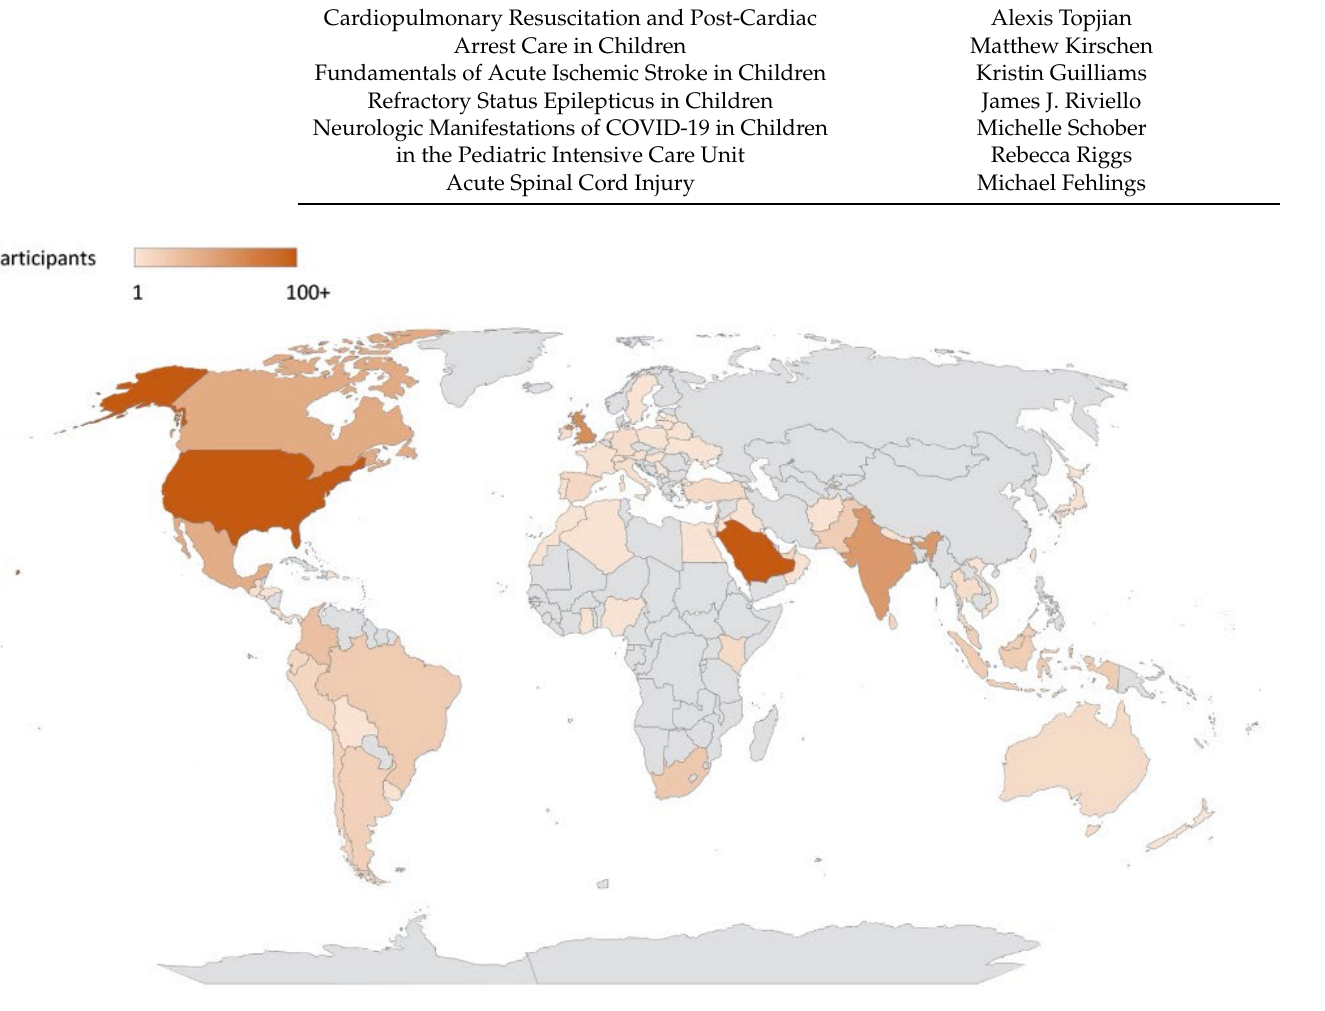
Table 2. Self-reported position of participants in the Pediatric Neurocritical Care Education Series.